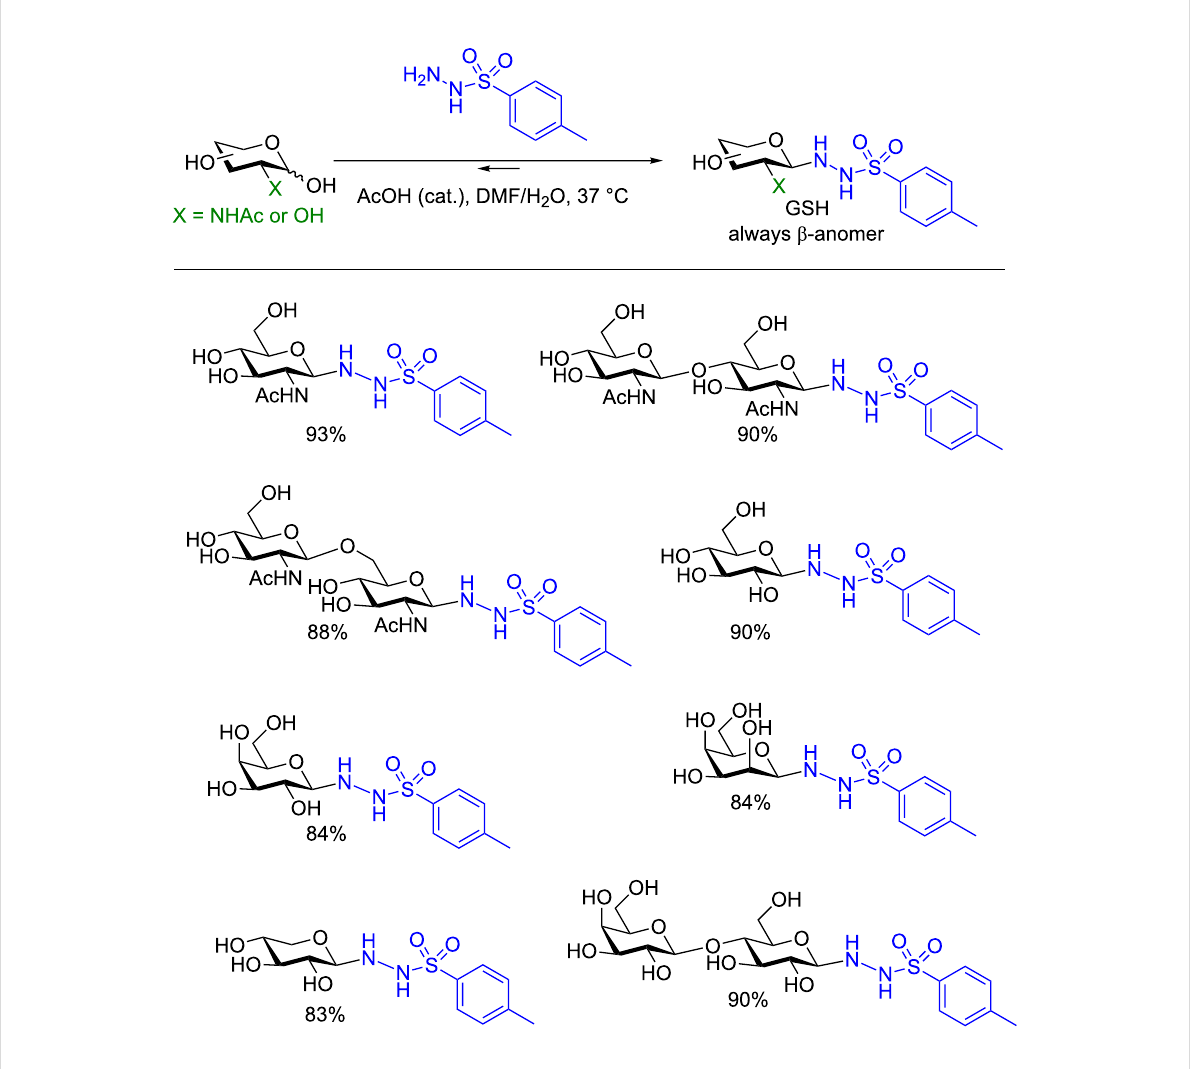
Figure 6: Protecting group-free synthesis of glycosyl sulfonohydrazides (GSH).